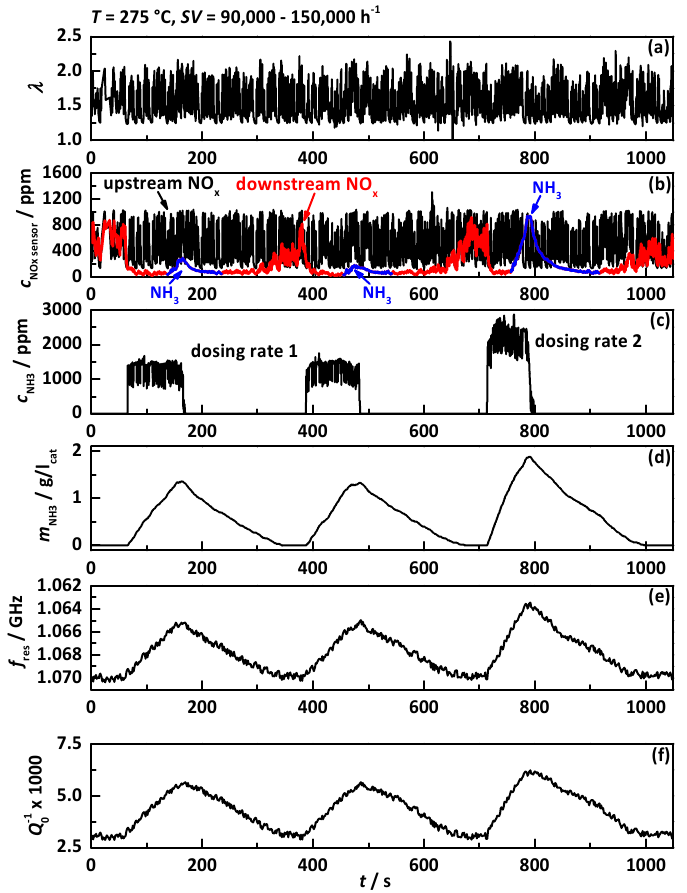
Figure 9. Experiment with continuously changing EGR rate with a catalyst temperature of 275 °C and a space velocity between 90,000 and 105,000 h − 1 with ( a ) the λ signal of the upstream NO x sensor; ( b ) the NO x sensor signals upstream of the DEF dosing (black) and downstream of the SCR catalyst (red: downstream NO x , blue: downstream NH 3 ); ( c ) dosed NH 3 concentration determined by NO x sensor signals up- and downstream of DEF dosing; ( d ) calculated amount of NH 3 stored on the catalyst; ( e ) resonance frequency f res in reverse scale and ( f ) the reciprocal unloaded quality factor Q 0 − 1 .